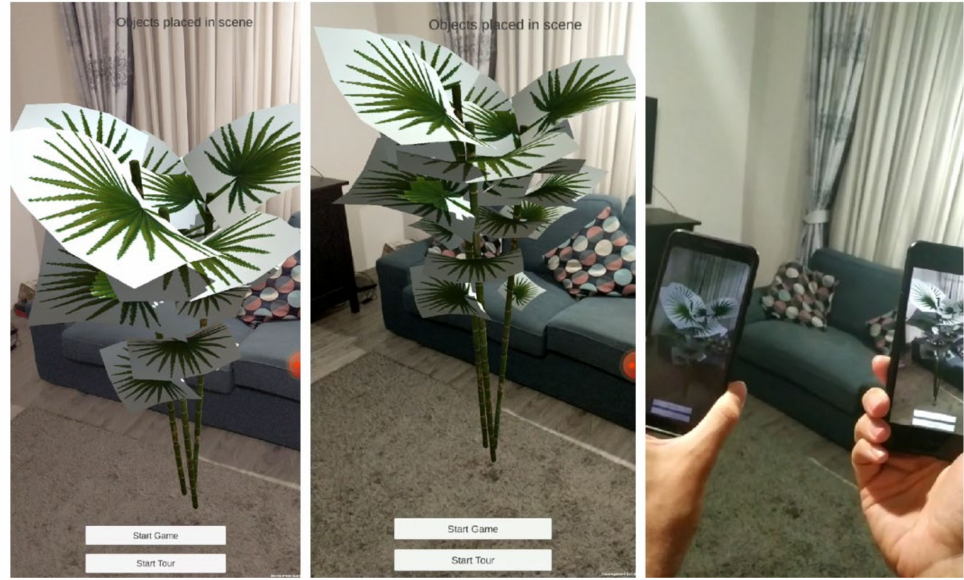
Figure 12. Piloting the computer vision-based localization with multiple users in a common aug- mented space: a screen capture of the first phone, displaying a 3D model of a bamboo ( left ), a screen capture of the second phone, displaying the same 3D model ( middle ), a screenshot from an external video filming the real scene and the two phones of the visitors ( right